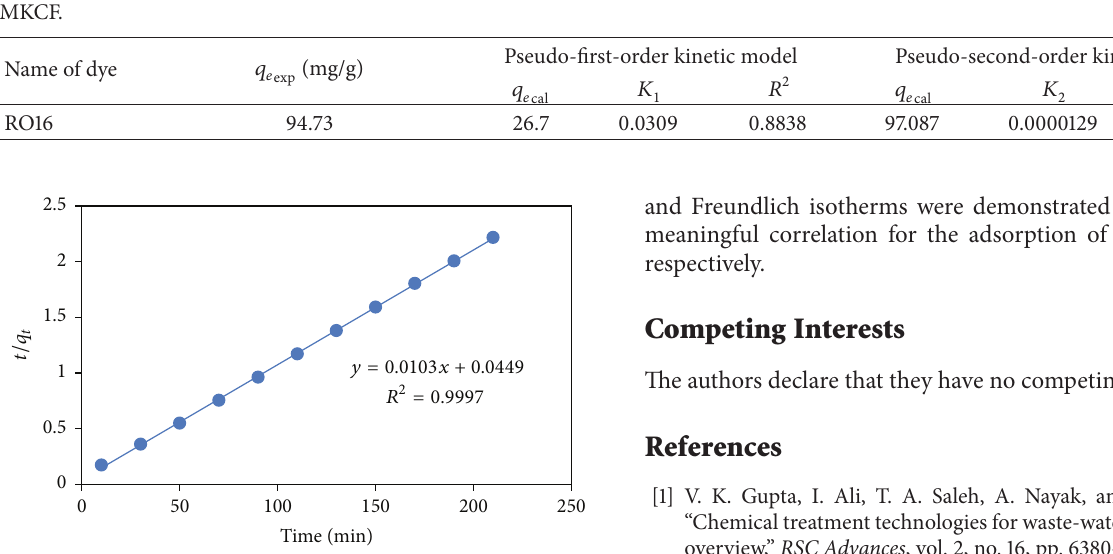
Figure 7: Kinetic study for adsorption of RO16 on MKCF by using pseudo-second-order kinetic model ( 𝐶 𝑜 = 100